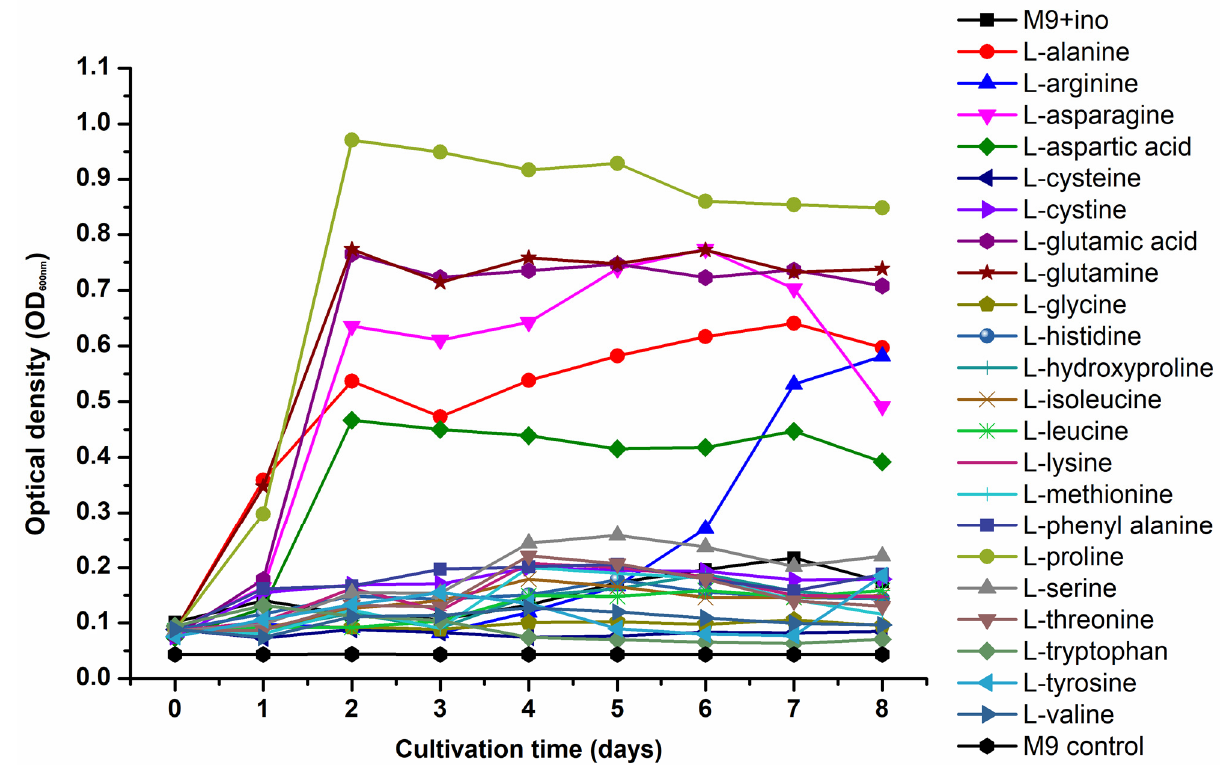
Figure 5. Amino acid utilization profile of K. rhaeticus ENS9b cells grown in M9 medium individually containing 22 L-amino acids. The test was conducted in 96-well microtiter plate wells containing a total volume of 200 µ L/well. The experimental controls included M9 medium containing cells but devoid of amino acid supplementation (M9+ino control) and M9 medium devoid of cells and amino acids (M9 control). The microtiter plates were incubated at 30 °C for 8 days and the OD 600 nm measurements were taken once every 24 h. The presented data is the averaged value obtained from triplicate cultivations. The error bars are not included for clarity.